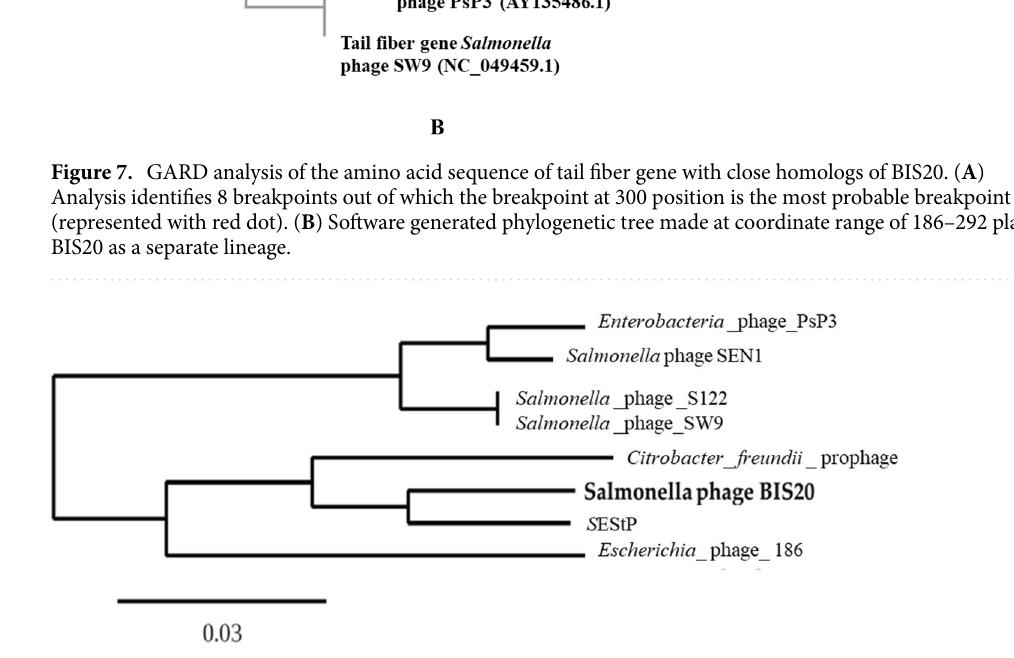
Figure 8. Phylogenetic tree of Salmonella phage BIS20 using whole-genome sequence of prophage and phage homologs in BLASTn. The maximum likelihood tree was generated using TreeDyn program and it provides a rough estimate of the relationships between related sequences in NCBI and Salmonella phage